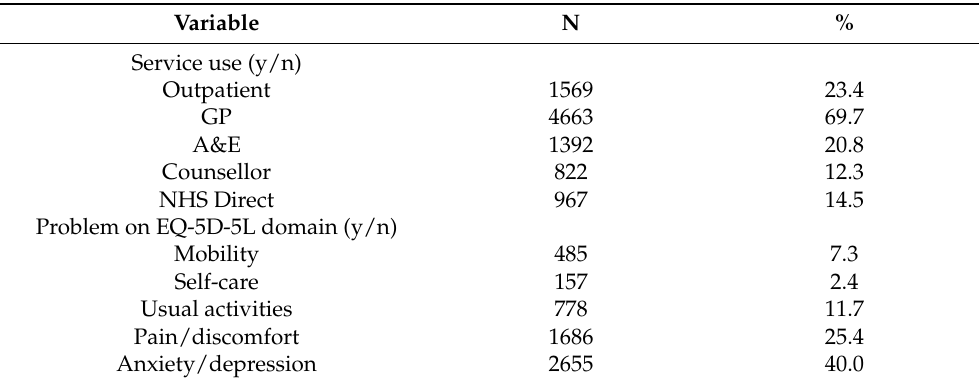
Table 3. Number (%) of respondents reporting service use in previous year and problems in EQ-5D-5L